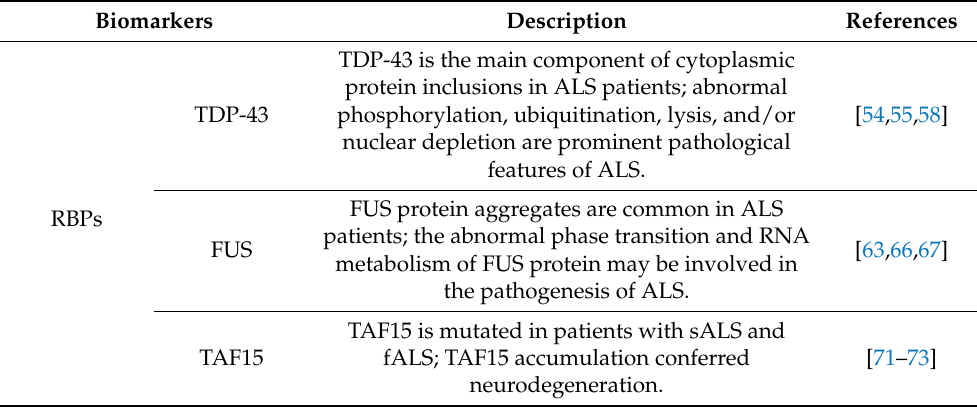
Table 1. Biomarkers of